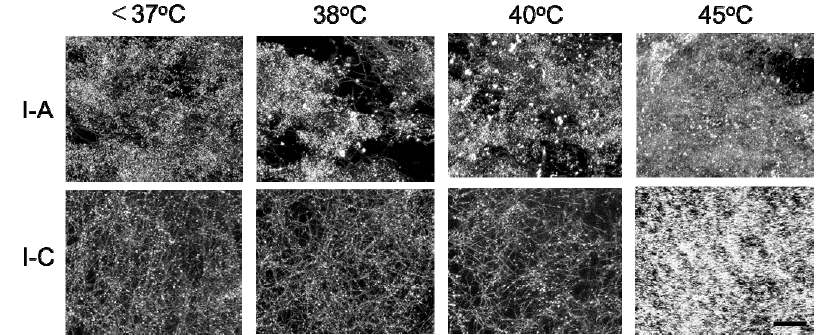
Figure 8. 3D laser microscopic images of collagen gels made from Cellmatrix type I-A and Cellmatrix type I-C, with and without AuNPs. Bar: 20 µ m.